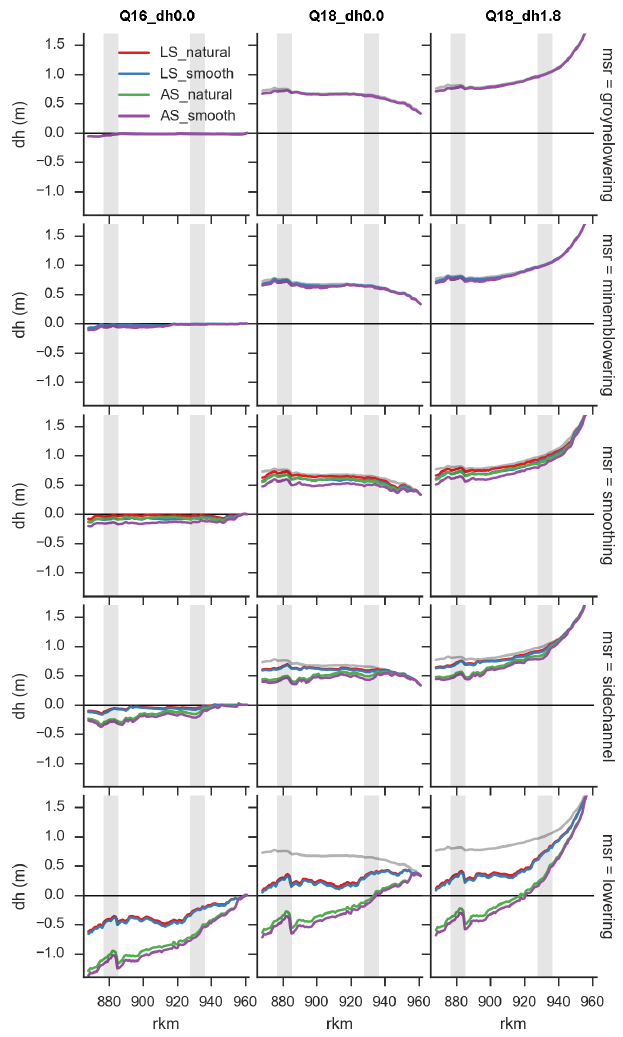
Figure 6. Water level changes (dh) at the river axis relative to the reference situation (Q16_dh0.0). The water levels of Q18_dh0.0 and Q18_dh1.8 are shown as grey lines. Water flows left to right, with the upper and lower area highlighted as grey vertical bands; see text for statistics. Measure (msr) type is indicated on the right. The grey lines in the middle and right column represent the effects of boundary conditions